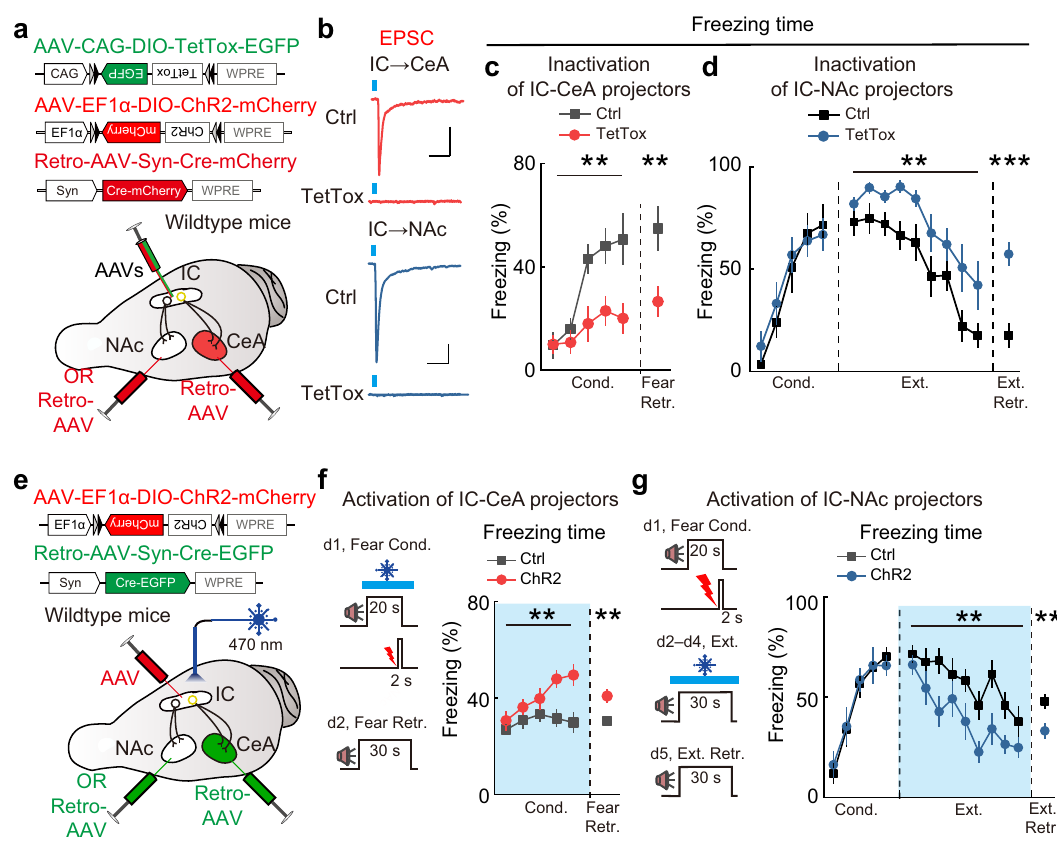
Fig. 5 | Effects of genetic silencing and optogenetic activation of IC-CeA or IC- NAcprojectorsonfearandextinctionmemories.a – d Effectsofgeneticsilencing of IC-CeA or IC-NAc projectors. a Schematic of AAV injections. b Patch-clamp recordingsfromtheneuronsinCeAandNAc.Scalebars,100ms,50pA. c Effectsof geneticsilencingofIC-CeAprojectors.Ctrl(EGFP), n =15mice,TetTox, n =16mice. Cond.: F (1, 29) =8.733, ** P =0.0061, two-way repeated measures ANOVA; Retr.: t (29) =2.853, ** P =0.0079, two-tailed unpaired Student ’ s t test. d Effects of genetic silencingofIC-NAcprojectors.Ctrl(EGFP), n =10mice,TetTox, n =10mice.Cond.: F (1,18) =0.1298, P =0.7228,two-wayrepeated measures ANOVA; Ext.: F (1, 18) =8.519, ** P =0.0092,two-wayrepeatedmeasuresANOVA;Retr.: t (18) =4.944,*** P =1.0482E − 04, two-tailed unpaired Student ’ s t test. e – g Effects of optogenetic activation of IC-CeAorIC-NAcprojectors. e SchematicofAAVinjections. f Effectsofoptogenetic